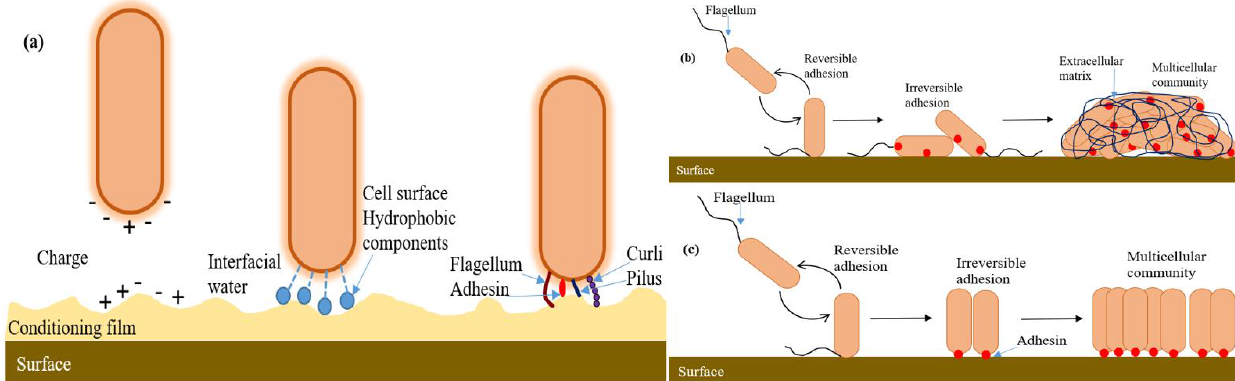
Figure 10. Biofilm formation of the microorganism. ( a ) First interactions between the surface and the bacterium. Once the bacterium is close to the surface, the heterogeneity of both the surface and the bacterium at the microscale level affects the adhesion process. Although the bacterial cell is usually negatively charged, the cell surface is highly heterogeneous, exhibiting different charges around the cell body. In addition, the presence of the conditioning film (orange) can modify the physicochemical properties of the solid surface (by altering charge, potential and surface tension) and thus affect local adhesion. At the nanoscale level, the thin layer of water (interfacial water, light blue) present on the surface can potentially be a barrier to cell adhesion. Hydrophobic components on the cell surface (dark blue), such as proteins, the polymeric brush layer and extracellular polysaccharides, can displace interfacial water between the bacterium and the surface and enhance hydrophobic interactions, thereby promoting close contact between the bacterium and the surface. Once the bacterium is sufficiently close to the surface (<1 nm), adhesins (red) and bacterial cell appendages (such as flagella (brown), pili (blue) and curli (purple)) can interact with the solid surface and have direct or indirect roles in adhesion. ( b ) For some bacteria, such as Pseudomonas fluorescens or Escherichia coli , initial surface contact is mediated by flagella and pili, which leads to polar adhesion. These bacteria transition from reversible to irreversible adhesion by repositioning the cell body to a longitudinal position. The adhesion is enhanced by the synthesis of protein or polysaccharide adhesins (LapA for P. fluorescens (red) or Pel for E. coli ). Irreversible adhesion leads to the formation of a multicellular community embedded in an extracellular matrix composed of polysaccharides, proteins and DNA. ( c ) Bacteria, such as Caulobacter crescentus or Agrobacterium tumefaciens , initiate surface attachment through the polar flagellum. Cells stay attached via their pole and achieve permanent adhesion through the secretion of a polar adhesin (red dots: holdfast for C. crescentus and UPP for A. tumefaciens ). Consequently, the incipient multicellular community is composed of cells mainly oriented polarly and is devoid of an extracellular matrix. For simplicity, the presence of a sinusoidal flagellum illustrates the motility of free-swimming bacteria, and the flagellum is the only external appendage shown. (Figure redrawn from [129]).